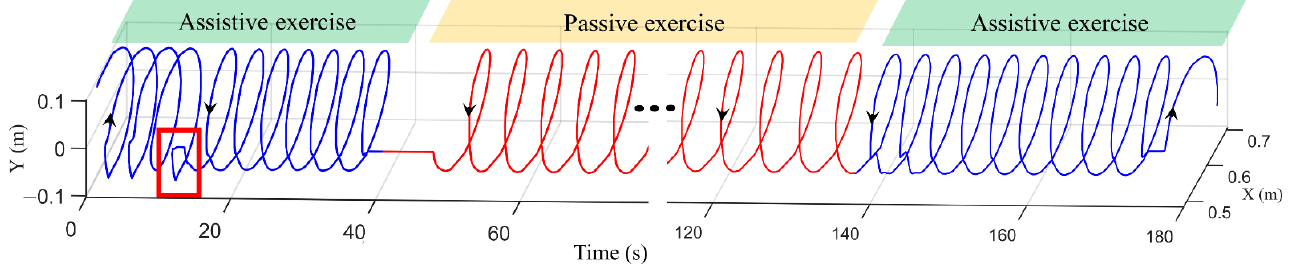
Figure 10. Actual training trajectory.